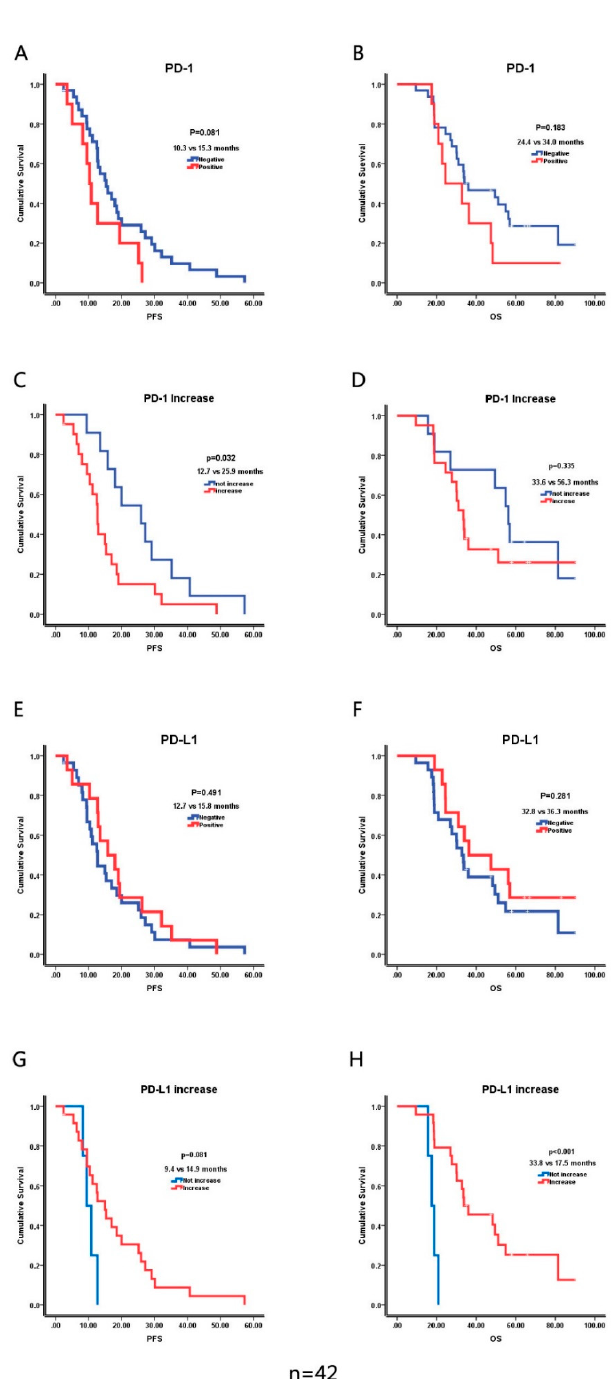
Figure 7. Correlation of the expression of PD-1, PD-L1 , increasing PD-1 , and increasing PD-L1 with PFS and OS. ( A ) Comparation of progress-free survival (PFS) in PD-1 negative group and PD-1 positive group. ( B ) Comparation of overall survival (OS) in PD-1 negative group and PD-1 positive group. ( C ) Comparation of PFS in the group that PD-1 expression didn’t increase after recurrence and PD-1 expression increased after recurrence. ( D ) Comparation of OS in the group that PD-1 expression didn’t increase after recurrence and PD-1 expression increased after recurrence. ( E ) Comparation of PFS in PD-L1 negative group and PD-L1 positive group. ( F ) Comparation of OS in PD-L1 negative group and PD-L1 positive group. ( G ) Comparation of PFS in the group that PD-L1 expression didn’t increase after recurrence and PD-L1 expression increased after recurrence. ( H ) Comparation of OS in the group that PD-L1 expression didn’t increase after recurrence and PD-L1 expression increased after